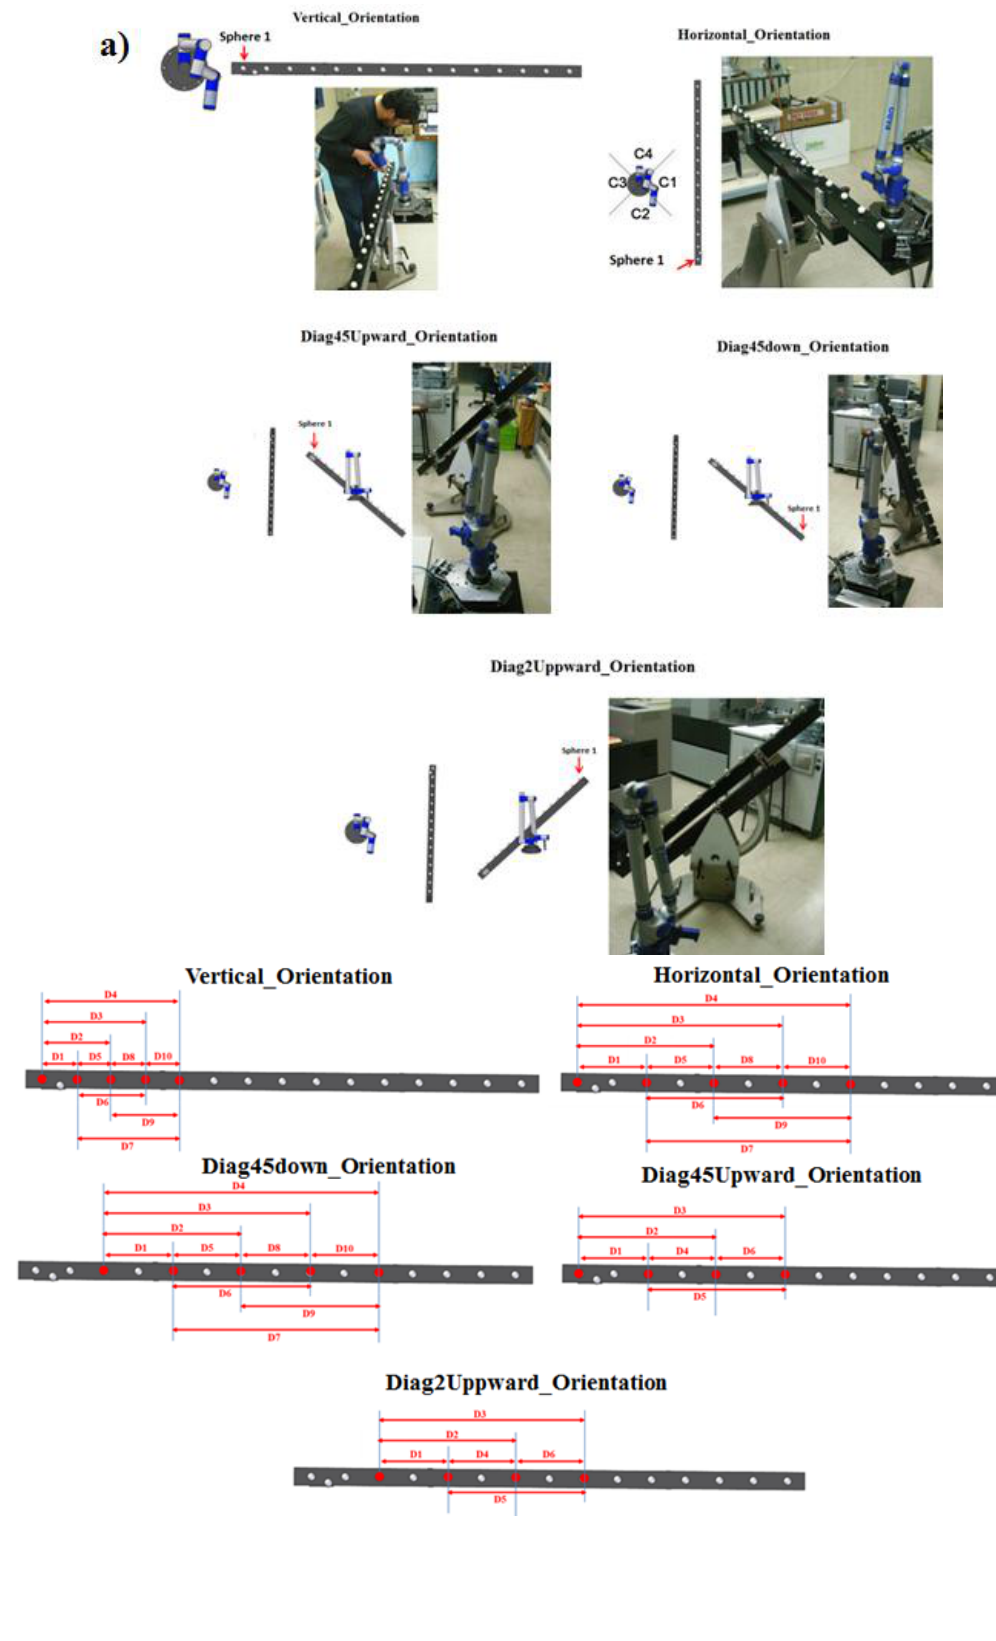
Figure 25. ( a ) Orientations of the ball bar gauge selected for the verification procedure; ( b ) Materialized distances between spheres centers